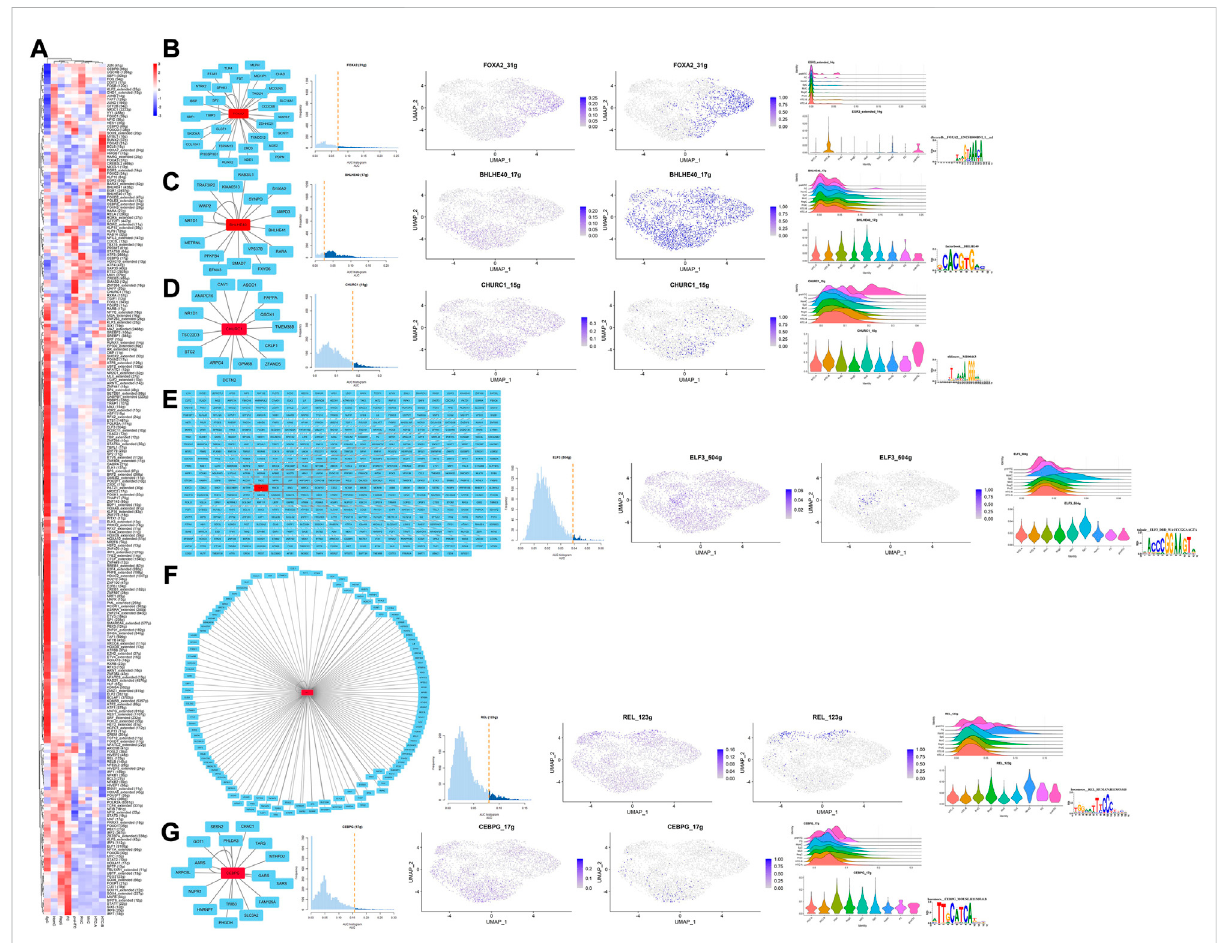
FIGURE 4 Results for SCENIC. (A) Heatmap presents the TFs ’ activity in each cell type, respectively; the color of the rectangle indicates the relative expression levels for each TFs. (B – G) From left to right, the PPI network, AUC histogram, ridge plots, and violin plots, the potential targets of speci fi c TFs in each cell type.